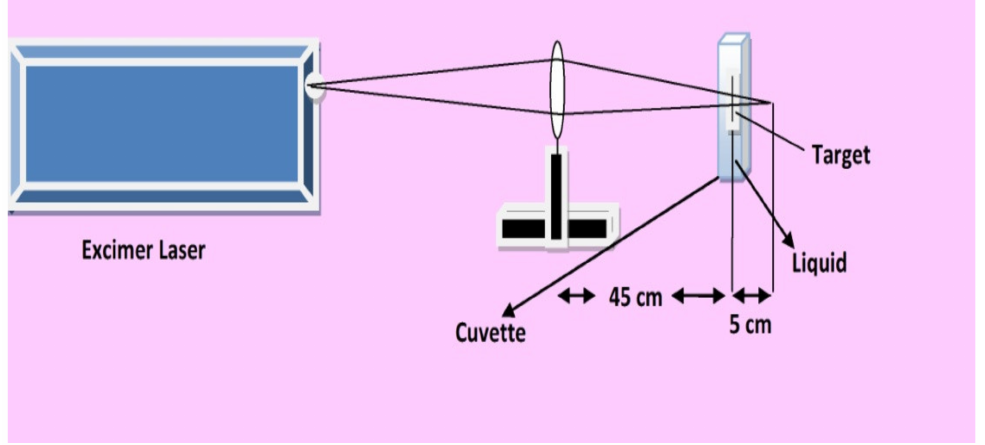
Figure 1. The schematic diagram of the experimental setup for laser